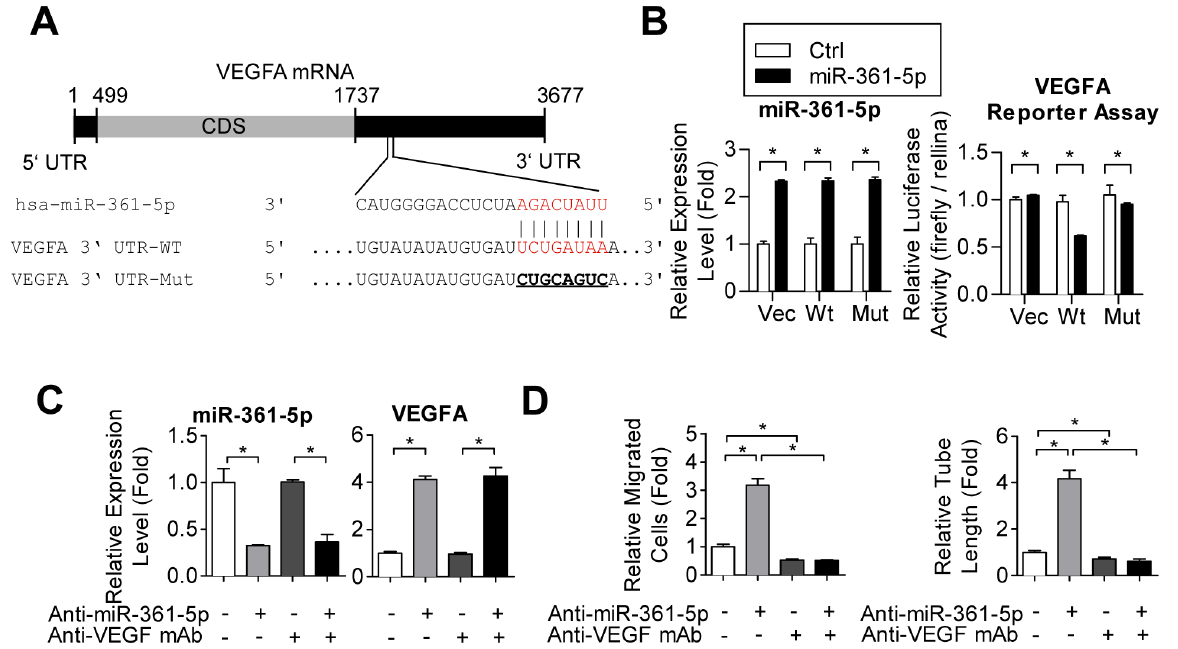
Figure 4. The miR-361-5p/VEGF pair contributes to CAD-EPC activities. ( A ) Structure of the VEGF transcript and the predicted binding site between the VEGF 3 9 UTR (untranslated region) and miR-361-5p. ( B ) A luciferase reporter plasmid containing either the miR-361-5p binding site (WT) or a mutant (Mut) binding site were co-transfected with miR-361-5p. The luciferase activity was assessed 2 days post-transfection ( right panel ). The expression levels of miR-361-5p were detected by RT-qPCR ( left panel ). *: p , 0.05 by one-way ANOVA test followed by Tukey’s post-hoc test. ( C–D ) Neutralization of VEGF in miR-361-5p-reduced (by antagomirs) CAD-EPCs suppresses cellular activities. miR-361-5p and VEGF levels in treated CAD- EPCs were determined by RT-qPCR ( C ). Transwell migration ( D, left panel ) and tube formation ( D, right panel ) assays were conducted on CAD-EPCs treated with the indicated antagomirs and/or the Avastin anti-VEGF mAb. Representative pictures are in Suppl. Figs. 2A-B online, and the quantitative results of the images are shown. *: p , 0.05 by one-way ANOVA test followed by Tukey’s post-hoc